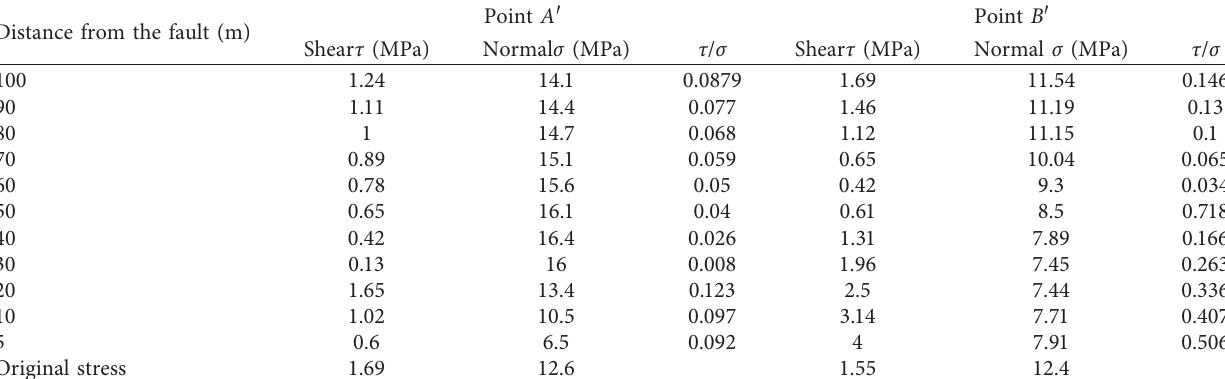
Table 4: Data on stress variation in the fault plane at different distances between the working face and the fault in footwall mining. Point A Distance from the fault (m)